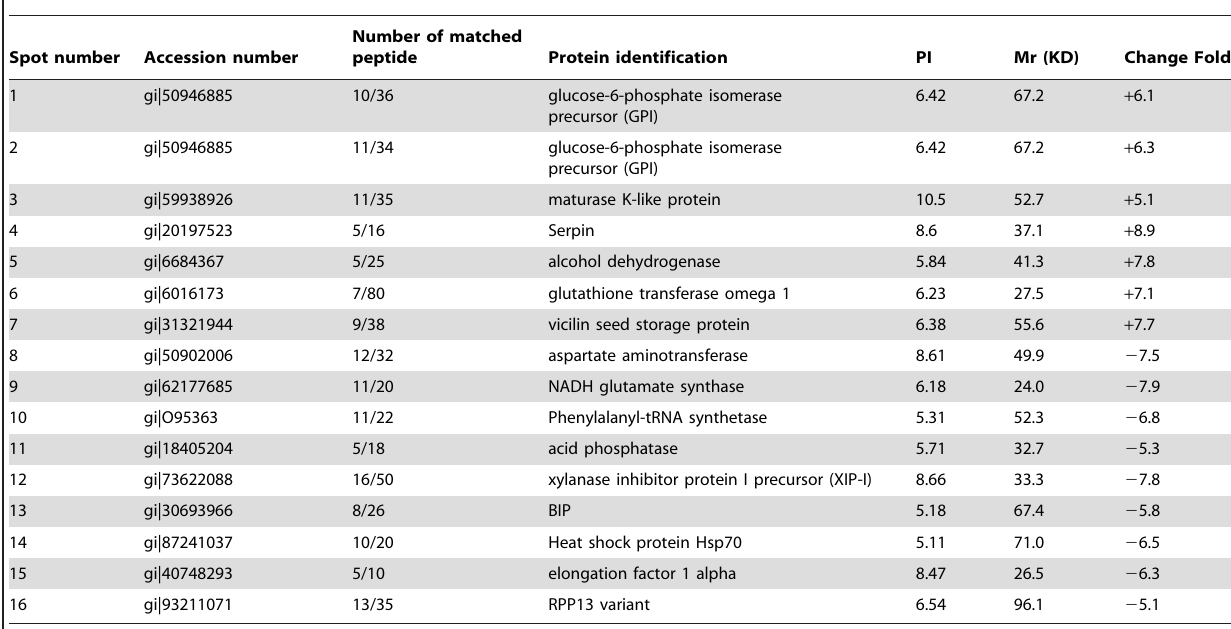
Table 3. The identification of the differential proteins in seeds imbibed for 2 d.